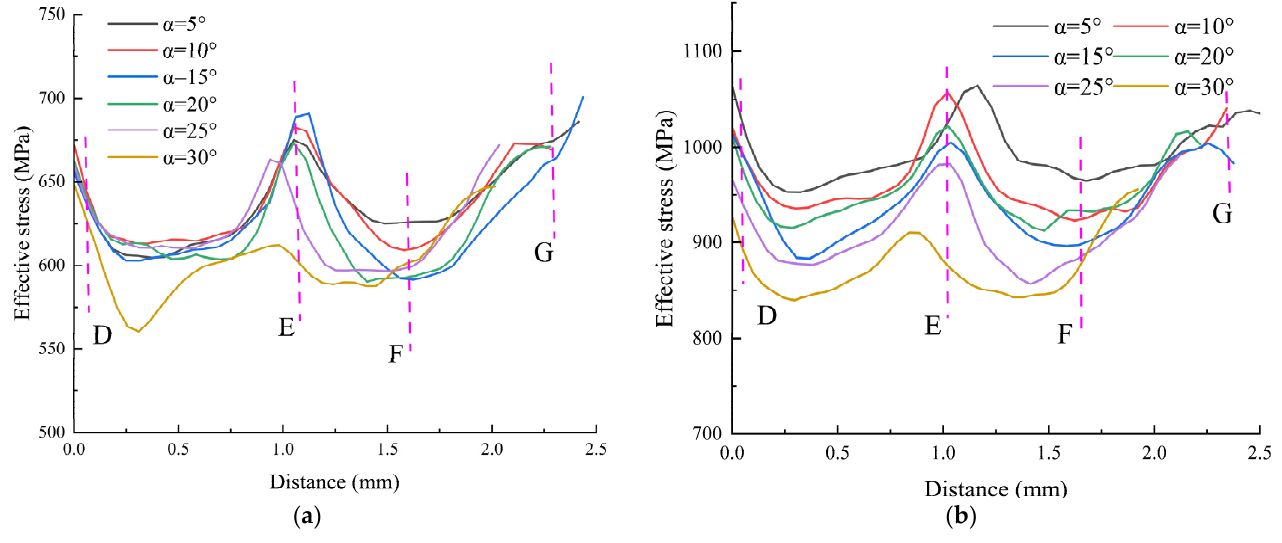
Figure 11. Variation curves of effective stress of the fins along DEFG trajectory direction under different conditions: ( a ): RT-EM; ( b ): CT-EM.